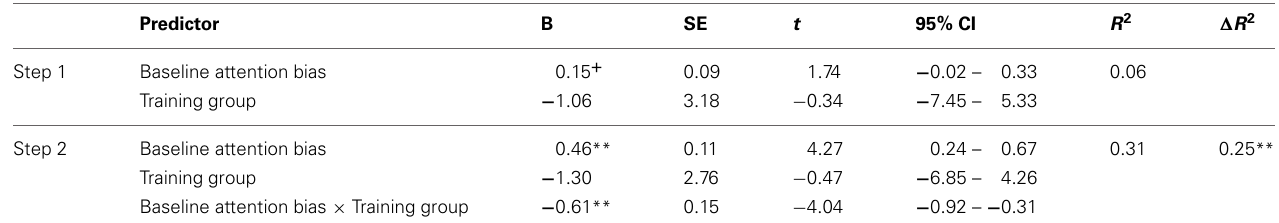
Table 3 | Estimated coefficients, standard errors, and 0.95 confidence intervals for predictors in the two steps of the regression model predicting stressor-related anxiety